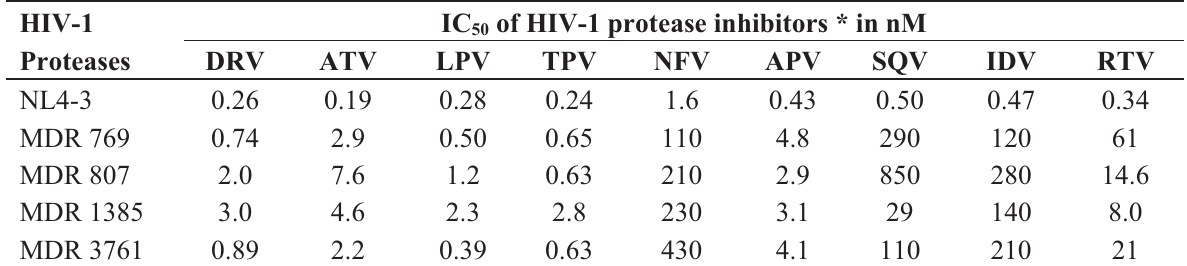
Table 1. IC and fold resistance of multi-drug resistant HIV-1 protease 50